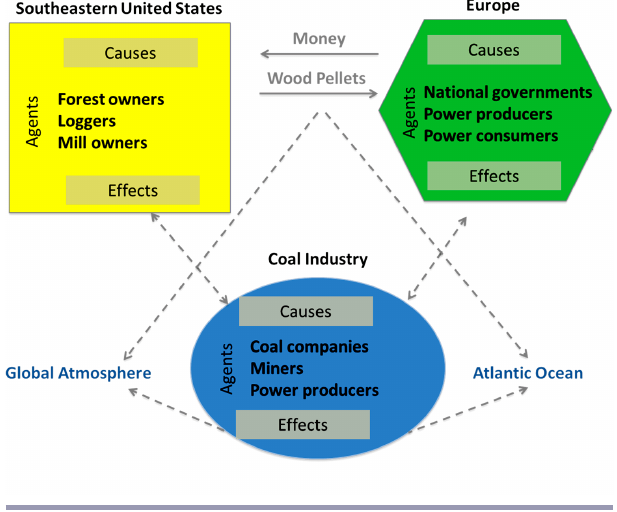
Fig. 1. Conceptual model of the transatlantic wood pellet trade system based on the telecoupling framework proposed by Liu et al. (2013). Solid arrows indicate direct flows of materials (wood pellets) and money between the sending system (southeastern United States) and the receiving system (Europe). Dotted arrows indicate potential connections (influences) on the spillover system (coal industry) as well as emissions of greenhouse gases and waste related to transatlantic shipping between the sending and receiving